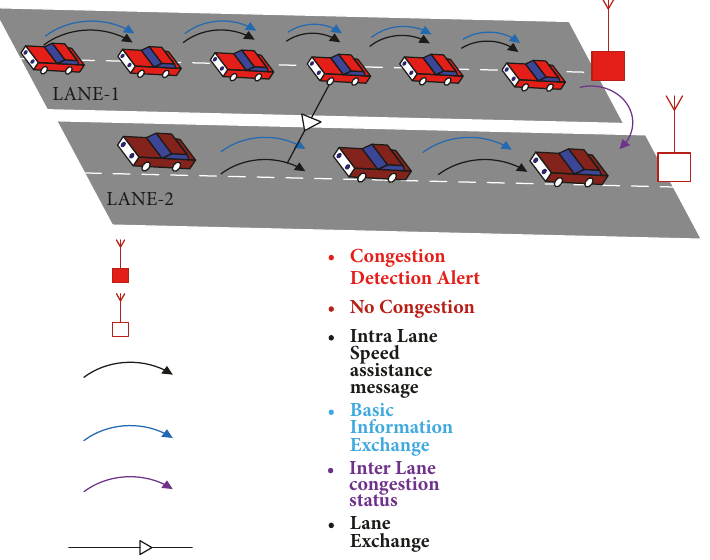
Figure 3: The MCDP enabled ITS